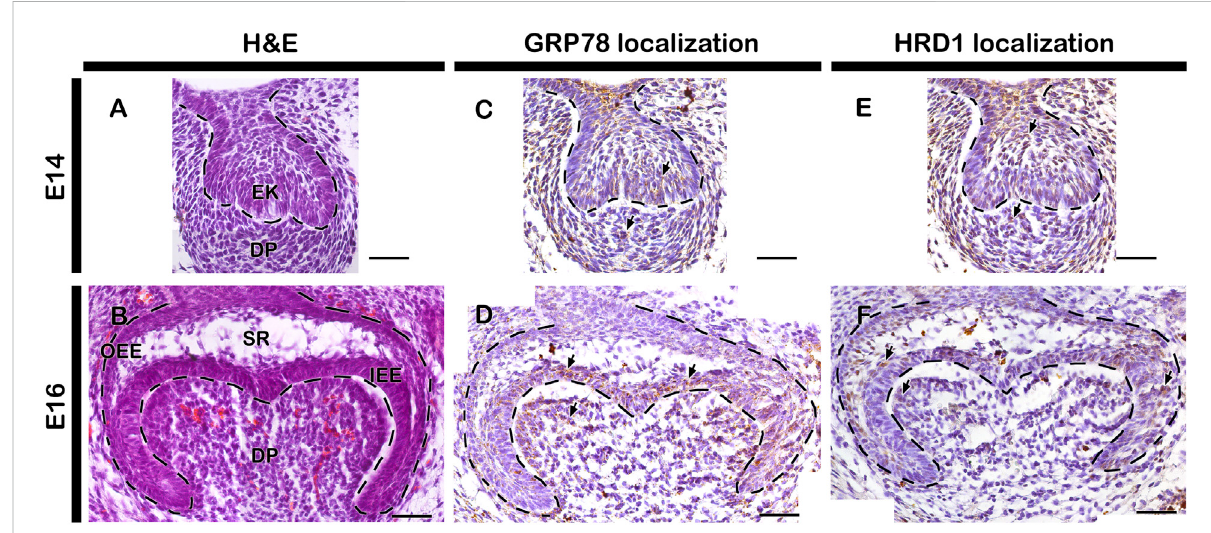
FIGURE 1 Histology and localization patternsof ER stress markers in mouse developing teeth. HE staining showing embryonic tooth germs at cap (A) and bell stage (B) of tooth development. Localizations of GRP78 and HRD1 at E14 and E16 tooth germs and counterstained with hematoxylin (C – F) . Dotted lines demarcate epithelial boundary (A – F) . Arrows indicate immunostaining positive cells. EK, enamel knot; IEE, inner enamel epithelium; OEE, outer enamel epithelium; DP, dental papilla; SR, stellate reticulum. Scale bars: 200 μ m (A,C and E) , 50 μ m (B,D and F)